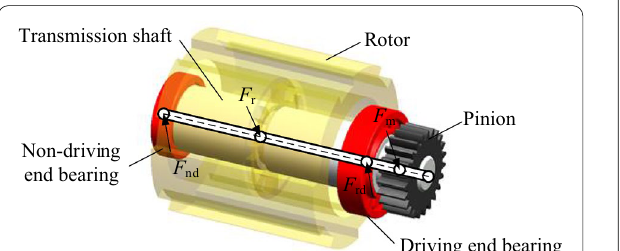
Figure 2 Schematic diagrams of: a the locomotive and b its traction power